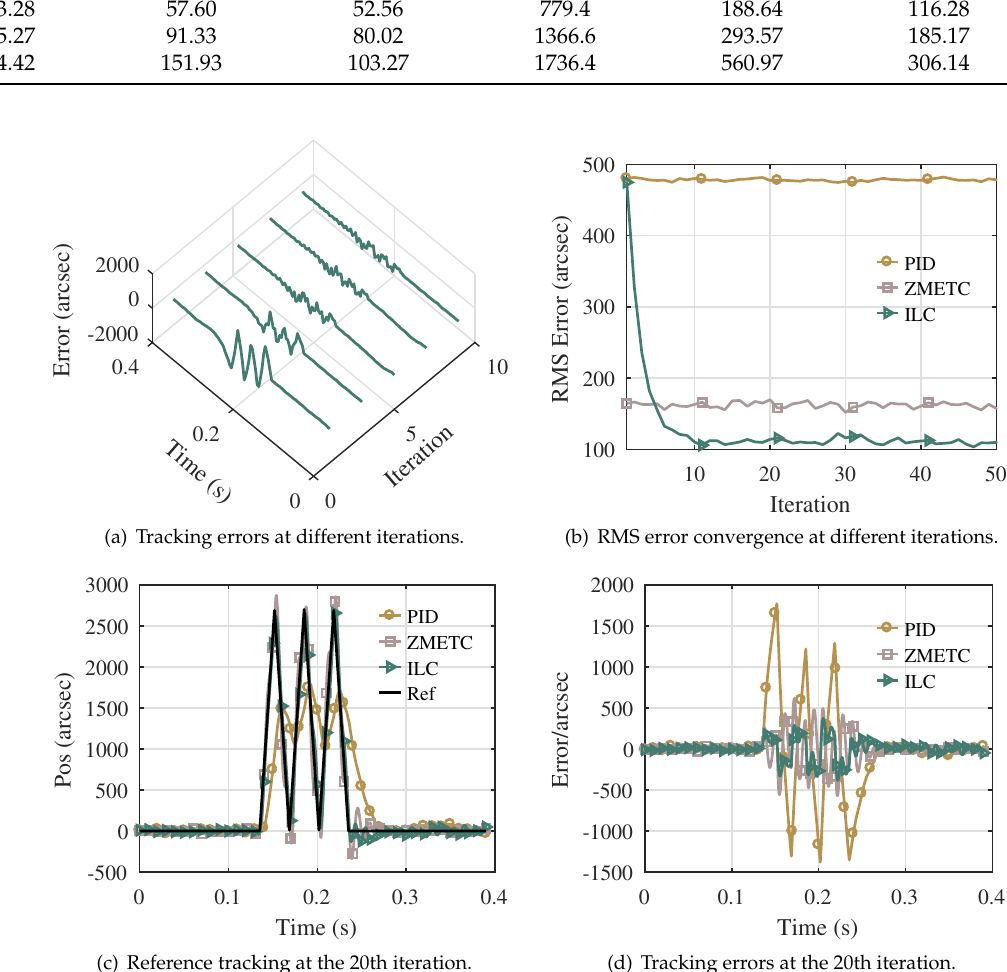
Figure 9. Triangular wave reference tracking performance compared with existing